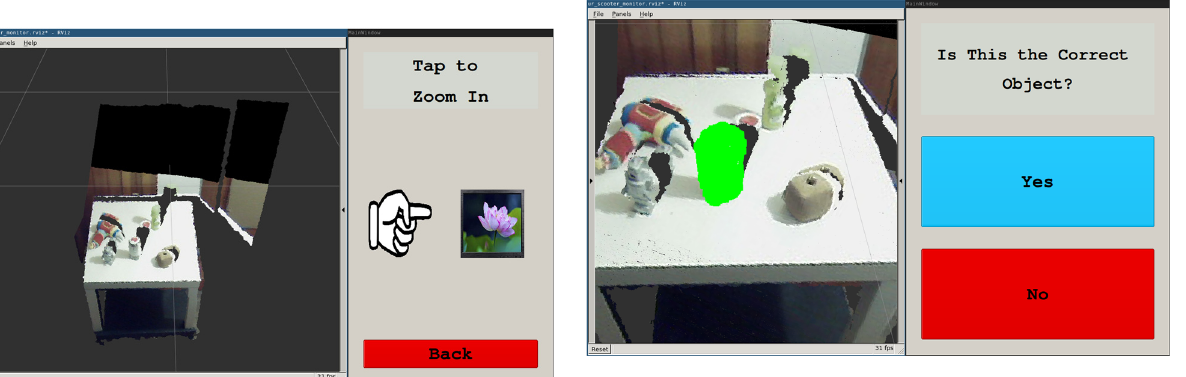
Figure 6: Interactive pointcloud representing the real world. The user can tap on an area to zoom in, and then tap on an object to select it.